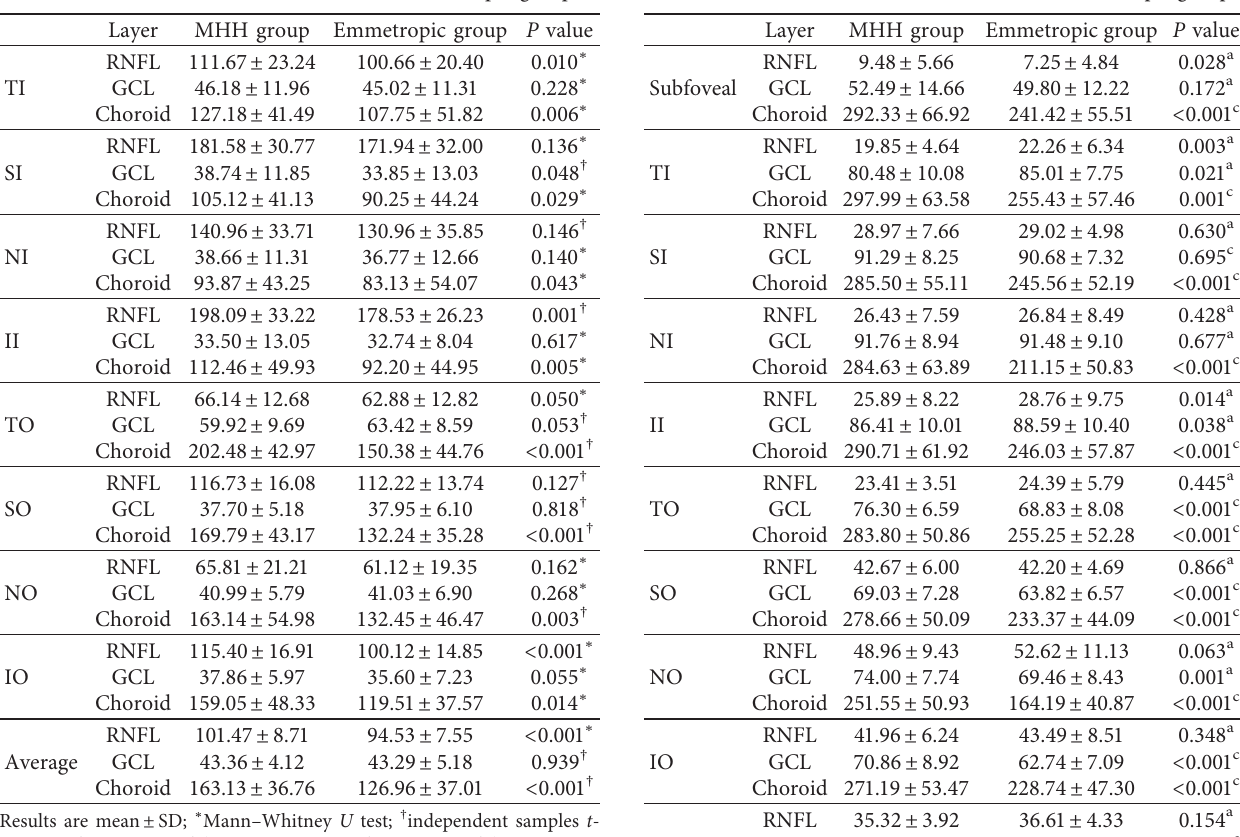
Table 2: Comparison of the thickness of the RNFL, GCL, and choroid in the disc between the MHH and emmetropic groups.